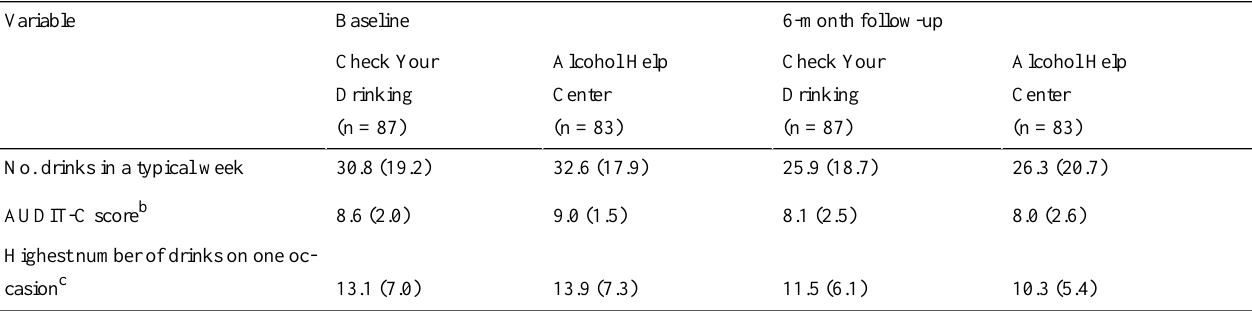
Table 1. Mean (SD) alcohol consumption and AUDIT-C a scores at baseline and 6-month follow-up by intervention condition.